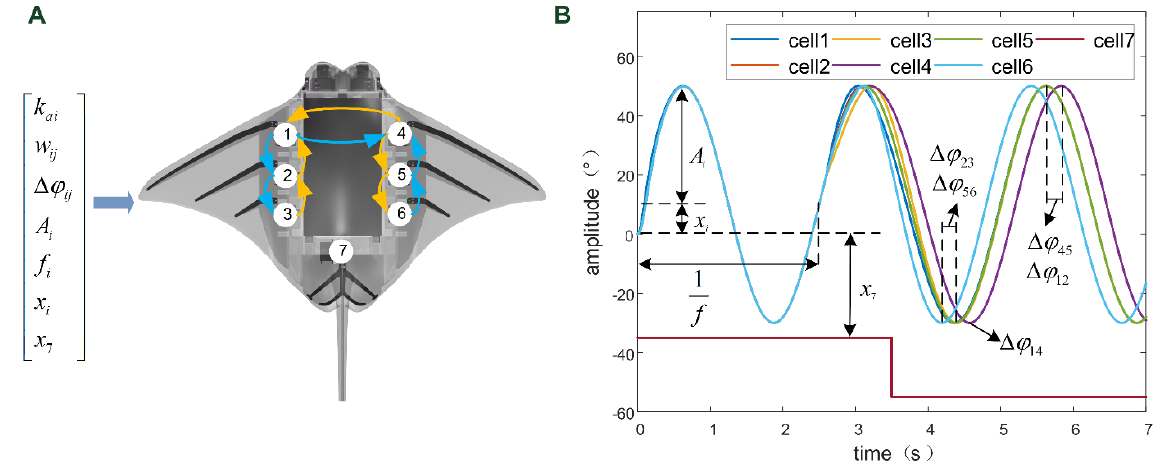
Table 2. The parameters of the CPG ‐ driven network.